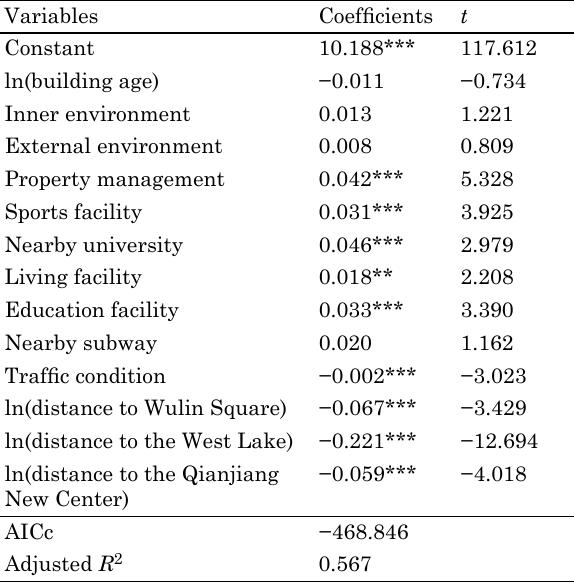
Table 2. Regression results of the traditional